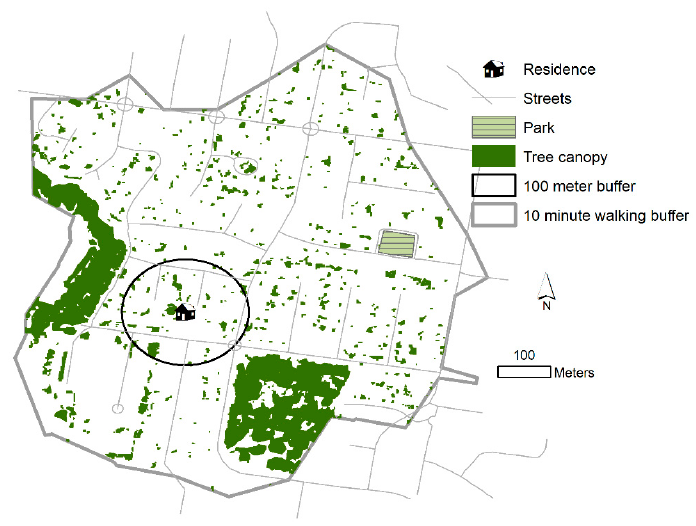
Figure 1. Sample residence with surrounding tree canopy, a park, and two types of buffers.